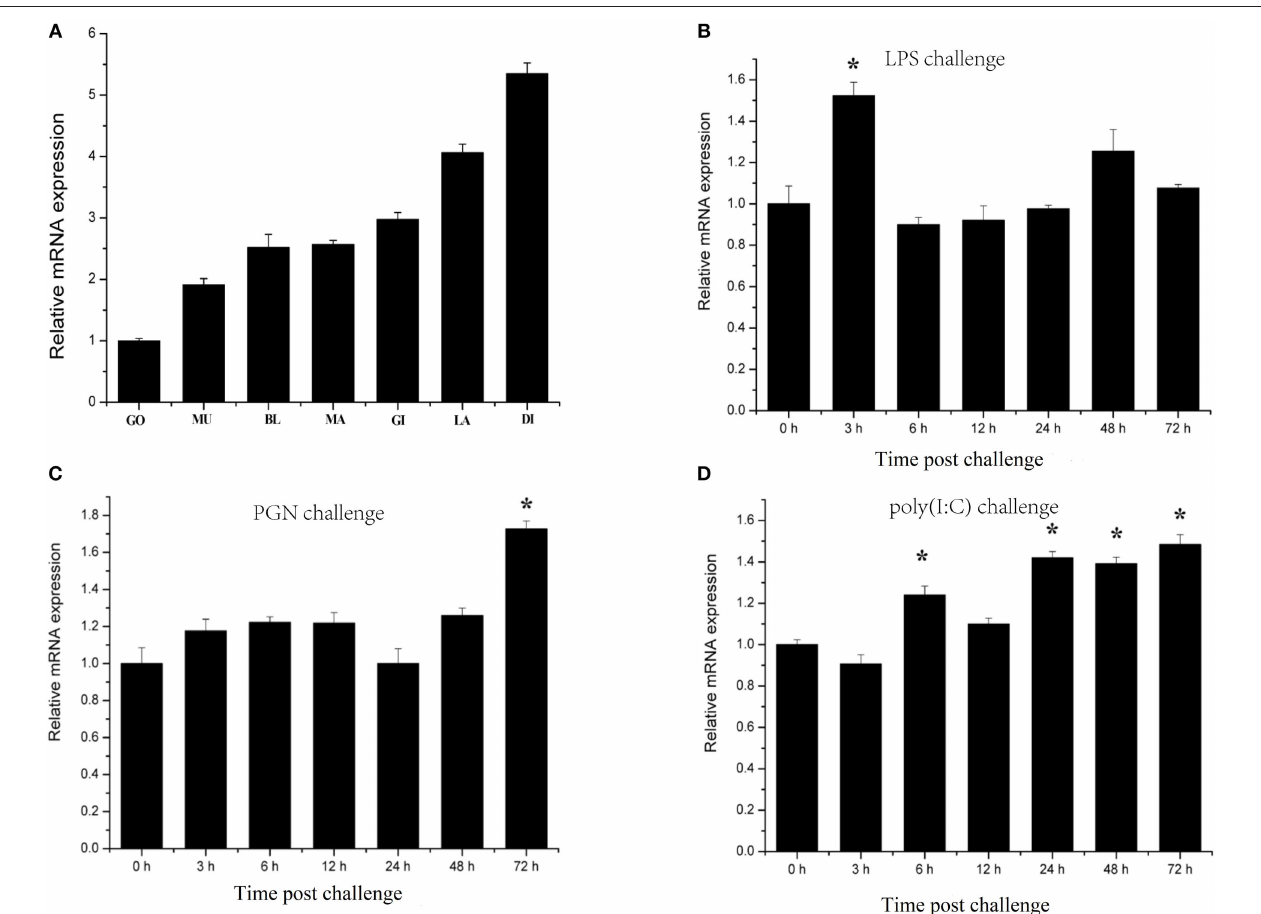
FIGURE 4 | Expression profiles of CgIKK α / β -2 mRNA in different tissues (A) and following challenge with different stimulants (B–D) as determined by qRT-PCR. Tissues: GO, Gonad; MU, Muscle; BL, Blood; MA, Mantle; GI, Gill; LA, Labial palp; DI, Digestive gland. β -actin gene expression was used as an internal control, and gonad was used as a reference sample. Vertical bars represent the mean ± SD ( N = 3). Challenges: the different stimulants is LPS, PGN, and poly(I:C). The expression level of CgIKK α / β -2 was determined at 0, 3, 6, 12, 24, 48, and 72h after challenge. β -actin gene expression was used as an internal control, and time 0h was used as a reference sample. Vertical bars represent the mean ± SD ( N =